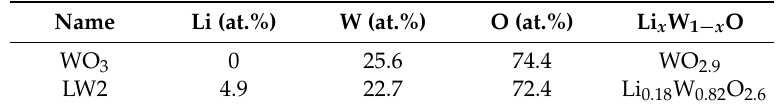
Table 4. Chemical analysis of WO 3 and LW2